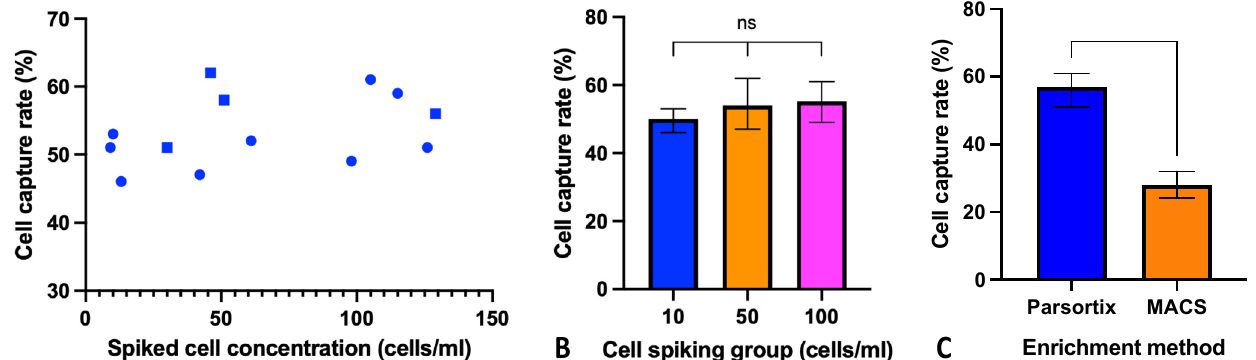
Figure 2. Spiked cell concentration does not impact capture rate, and microfluidic enrichment is superior to negative depletion protocol. ( A ) FaDu and SCC040 cells were spiked into 4 mL of healthy donor (HD) blood at the stated concentrations. Each symbol represents an individual experiment (FaDu cells round dots and SCC040 cells square dots). ( B ) Data set of capture rates in figure A grouped into target concentrations of ≈ 10, 50 and or 100 cells/mL. No significant difference between groups ( p = 0.415). ( C ) FaDu cells were spiked into 4 mL of HD blood at concentrations of 100 cells/mL and enriched using Parsortix or CD45 depletion (MACS) to test cell capture rate ( n = 3 per protocol). Comparison between Parsortix and MACS depletion was not performed on fixed cells, due to the incompatibility of lymphoprep density gradient centrifugation with fixed cells.